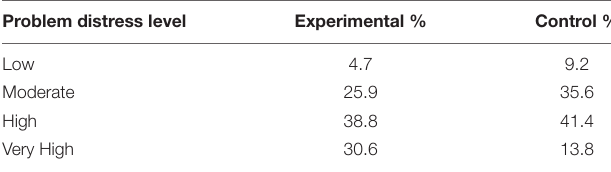
TABLE 3 | Problem distress level by group.